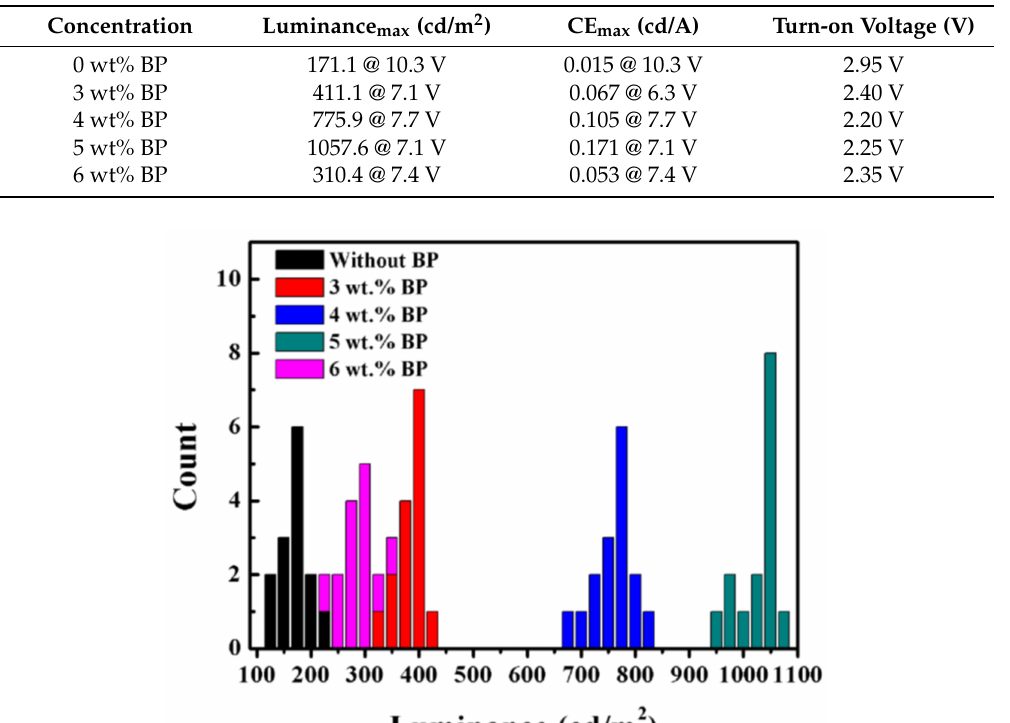
Figure S1. UV–VIS absorption of MAPbBr3 films with each BP concentration; Figure S2. PL spectra of the films with each BP concentration; Figure S3. Cross-SEM of the perovskite films: ( a ) CH 3 NH 3 PbBr 3 film consisting of micron-scale single crystals; and ( b ) poly-crystalline CH 3 NH 3 PbBr 3 film. Figure S4. The statistical results of the thickness of the films: (a) the perovskite film without BP; and (b) the perovskite film with 5 wt%